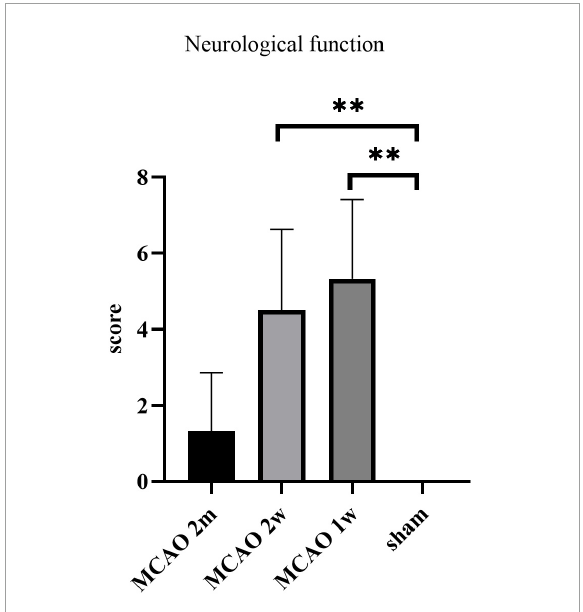
FIGURE9 The neurological function scores. The neurological function deteriorated at the 1st week and the 2nd week after MCAO, and gradually recovered at the 2nd month. ∗∗ P < 0.01. MCAO, middle cerebral artery